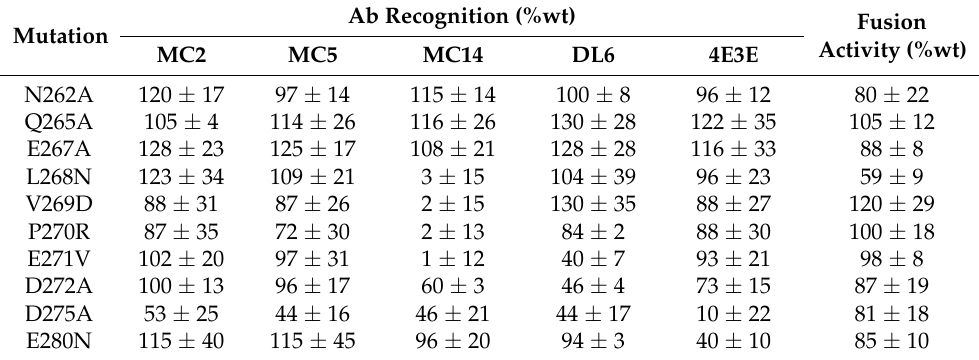
Table 1. Summary of the point mutations generated in region